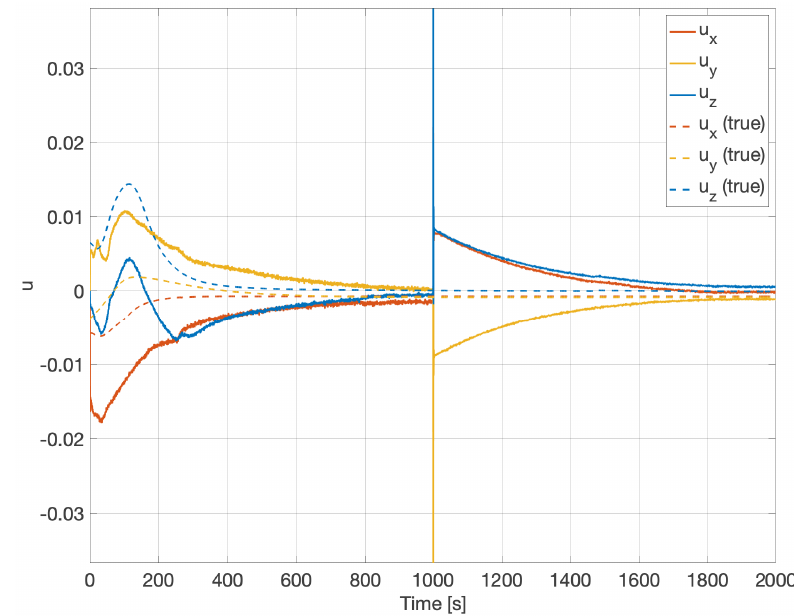
Figure 8. Reconfiguration and recalibration